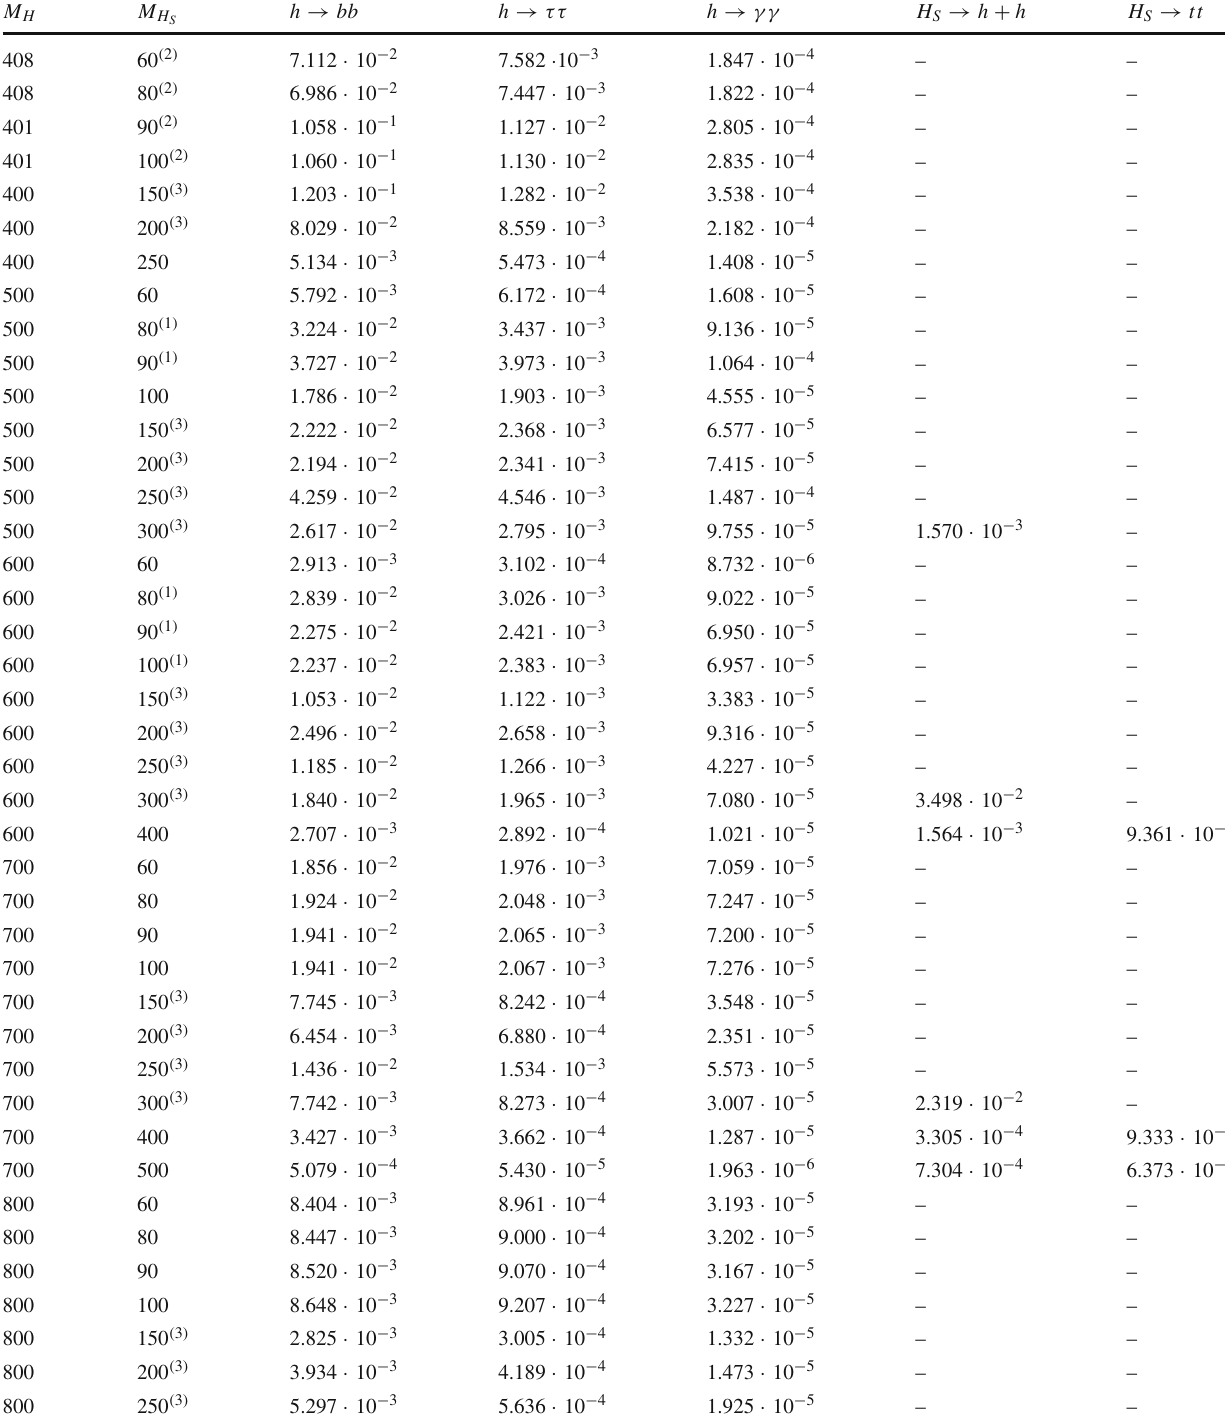
Table 1 Possible cross sections (in pb) at 13 TeV for ggF → H → ( H → bb ) + ( h → X X ) , X X = bb ,ττ,γγ (columns 3-5), ggF → S H → ( H S → h + h ) + h (column 6), ggF → H → ( H S → tt ) +